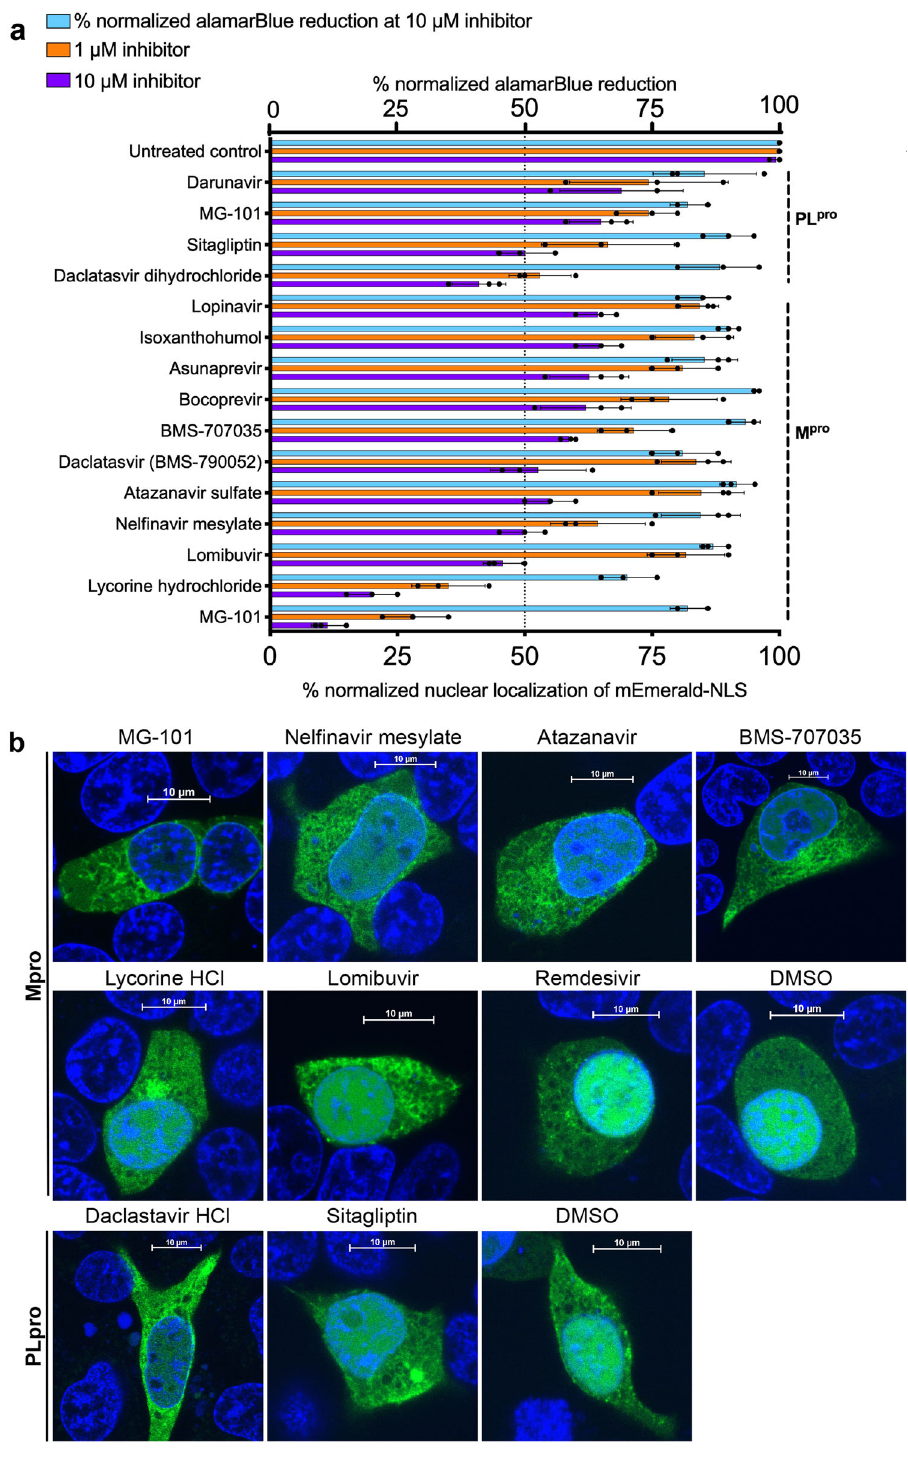
Fig. 2 SARS-CoV-2 protease inhibitors selected after ICP assay and quanti fi cation. a ImageJ quanti fi cation of mEmerald-NLS localization to the nucleus identi fi es six Mpro inhibitors and two PLpro inhibitors with approximately 50% reduction in protease activity. The selection criteria were 50% reduction at 10 µ M and 25% at 1 µ M concentrations without cytotoxicity. The distribution of mEmerald-NLS was quanti fi ed from cells in each image ( n = 3) using ImageJ, the ratio between fl uorescence in the nucleus, and total fl uorescence calculated and normalized to that of untreated cells. b Live confocal images of HEK293T cells expressing PLpro or Mpro at 6 h post-transfection. Cells were treated with 10 µ M inhibitors as indicated and nuclei were stained using Hoechst stain. Cells treated with DMSO and Remdesivir are negative